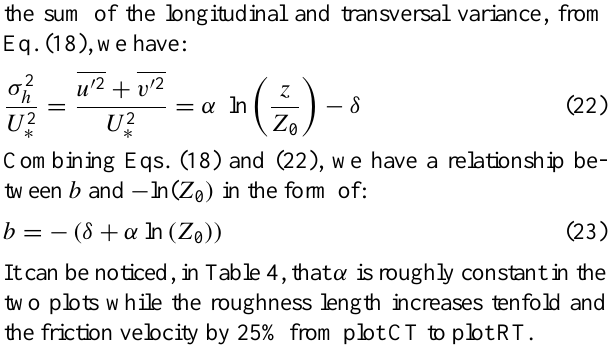
Figure 6: Linear regression between b and the opposite of the logarithm of the roughness length. 31